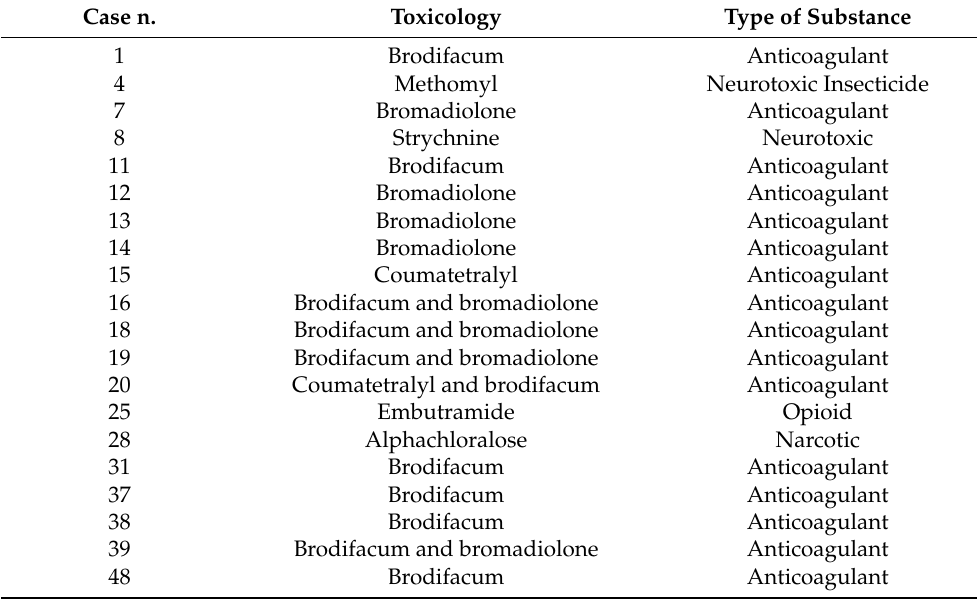
Table 2. Toxicological results and description of the type of substance identified in the 20 dogs that had positive results for the toxicological analyses. Case